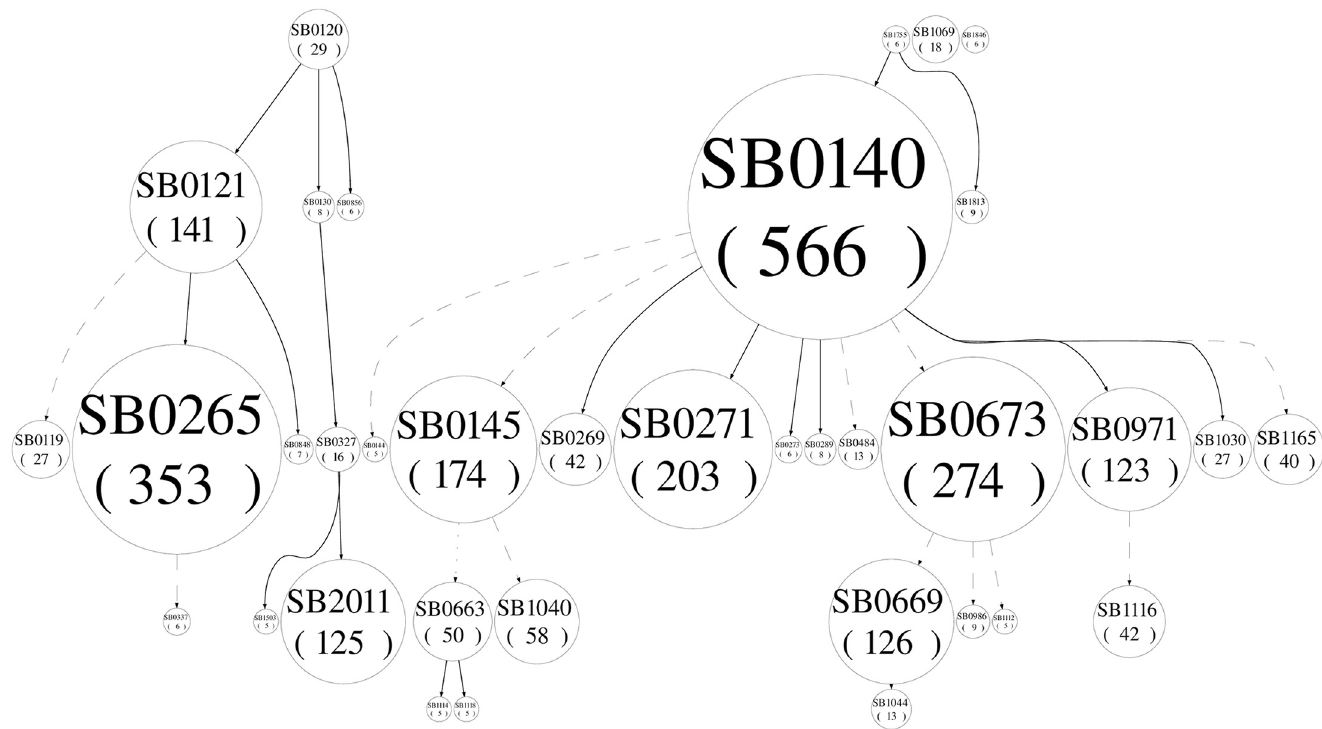
Fig 1. Spoligoforest of M . bovis spoligotypes obtained from cattle in Mexico and those from countries with history of trade of cattle with Mexico: Australia, Canada, New Zealand and The Unites States of America. Nodes are labeled with the SB identifier as indicated in www.mbovis.org; numbers in the circle indicate cluster size. The lines between nodes reflect hypothetical evolutionary relationships among spoligotypes with arrows denoting descendence. Continuous lines indicate stronger relationship.